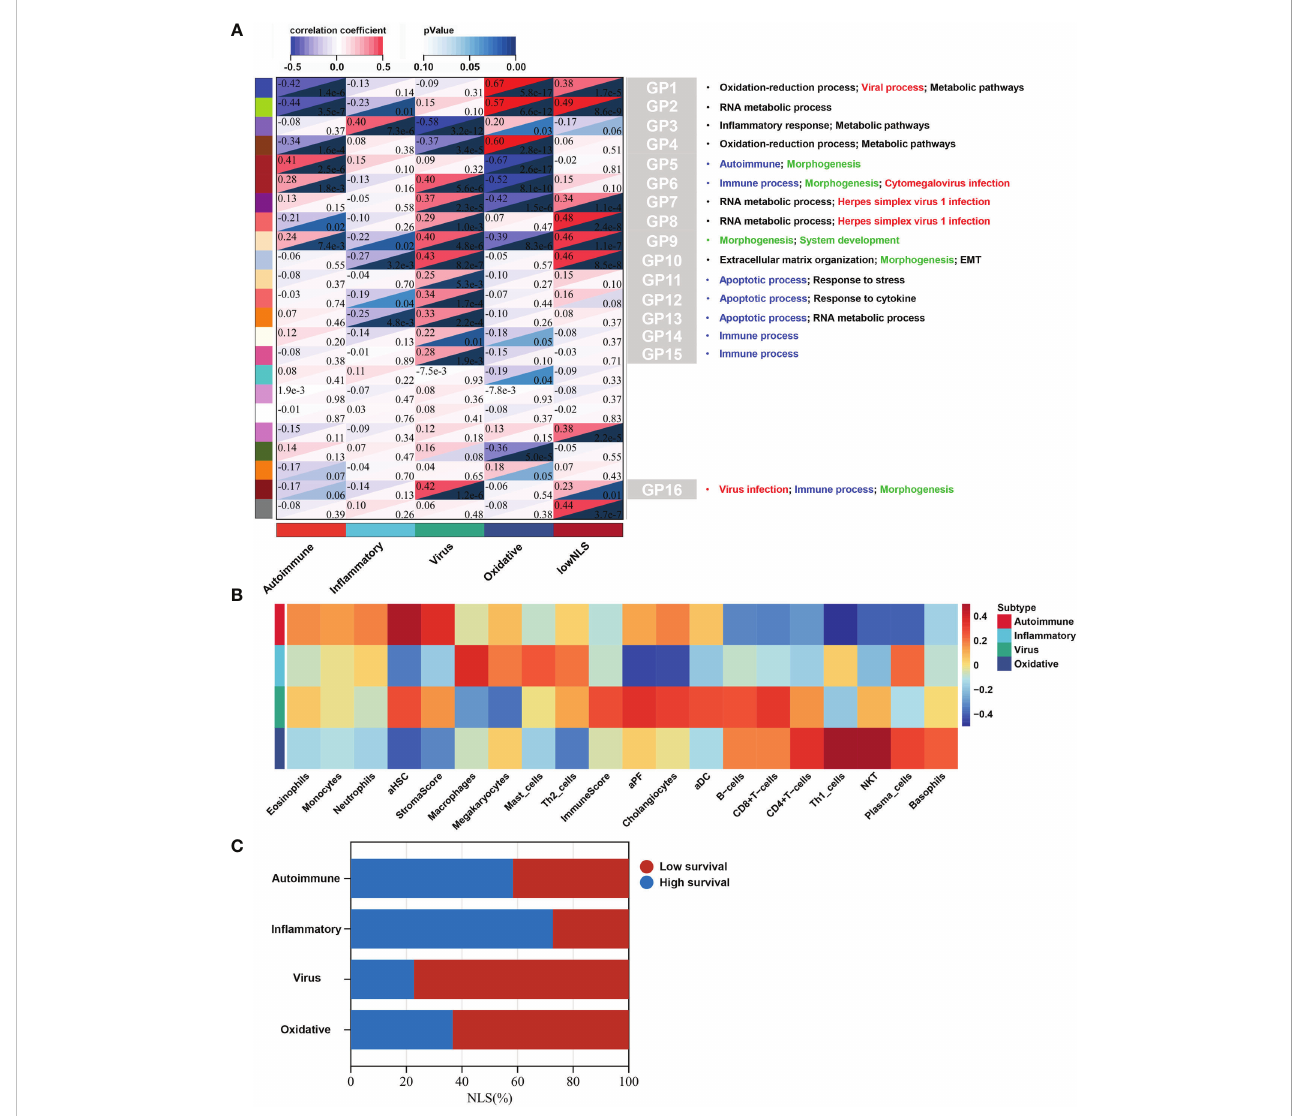
FIGURE 3 Biological function, biliary fi brosis, immune and prognostic information for each molecular subtype in the training dataset. WGCNA analysis of the training dataset identi fi ed gene modules representing different biological processes (A) . Correlation heatmap revealed the enrichment scores of immune or biliary fi brotic cells were upregulated in each subtype (B) . The percentage of low or high NLS was signi fi cant different between these four subtypes (C) . aDC, activated dendritic cell; aHSC, activated hepatic stellate cell; aPF, activated portal fi broblast; NLS, natural liver survival; NKT, natural killer T cell; WGCNA, Weighted Gene Co-expression Network